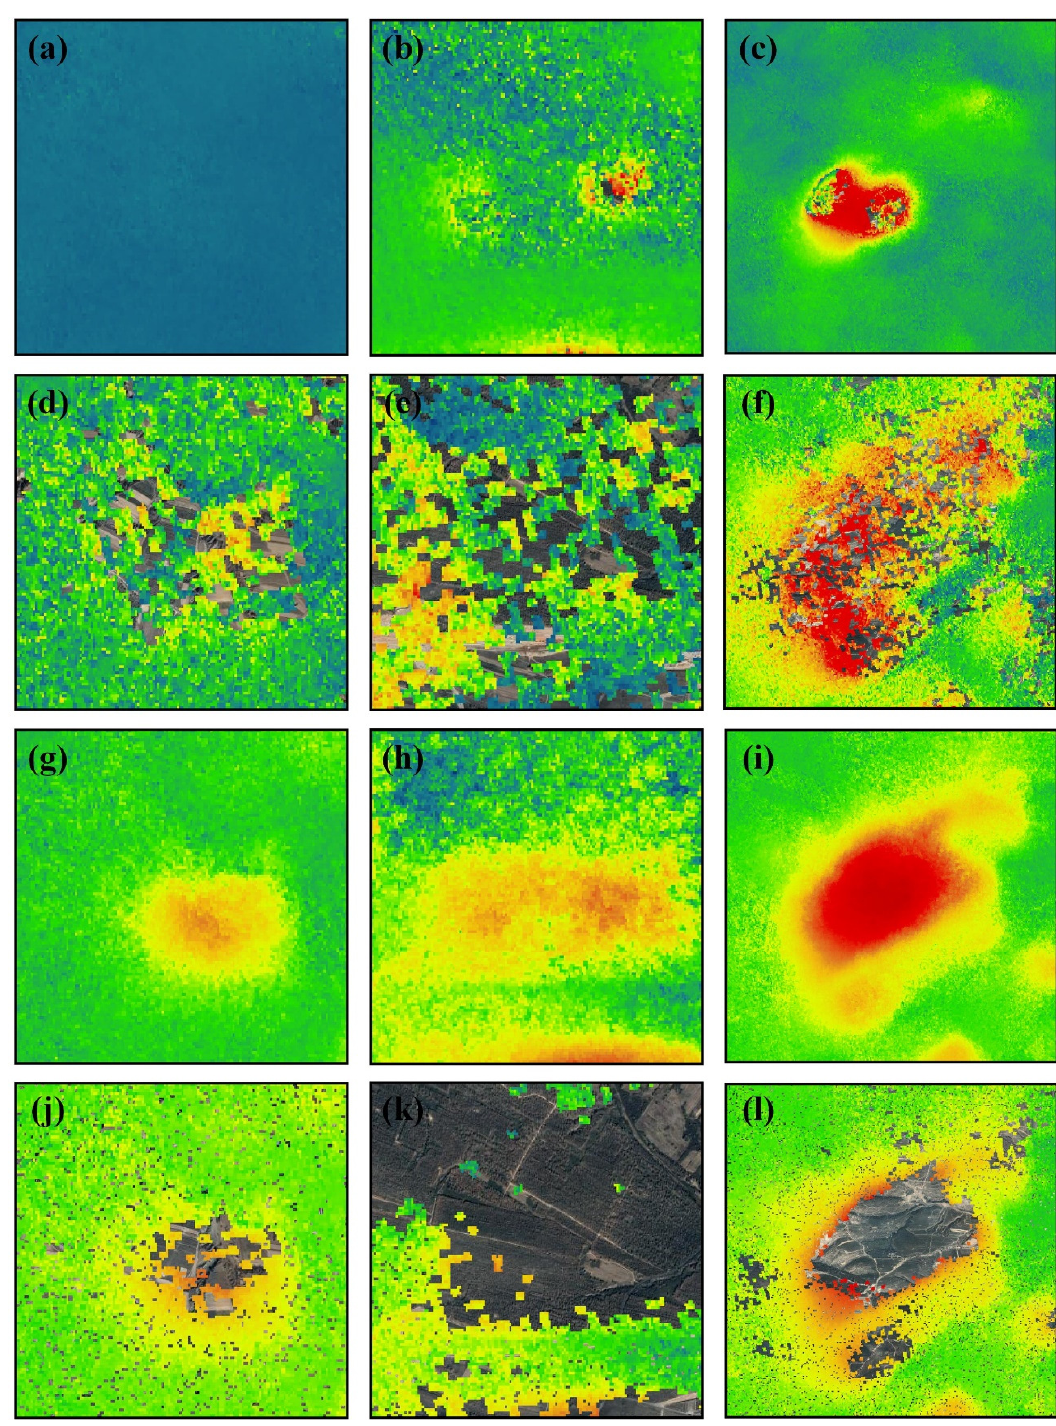
Figure 9. Three mining deformation areas identified using DInSAR, stacking-InSAR and SBAS-InSAR: ( a – c ) are DInSAR results with short spatiotemporal baselines; ( d – f ) are DInSAR results with a long spatiotemporal baseline; ( g – i ) are stacking-InSAR results; ( j – l ) are SBAS-InSAR results. The three columns are the regions with small deformation, moderate deformation with lush vegetation and violent deformation. The color bar results of DInSAR, stacking-InSAR and SBAS-InSAR are consistent with Figures 4, 5 and 7, respectively.